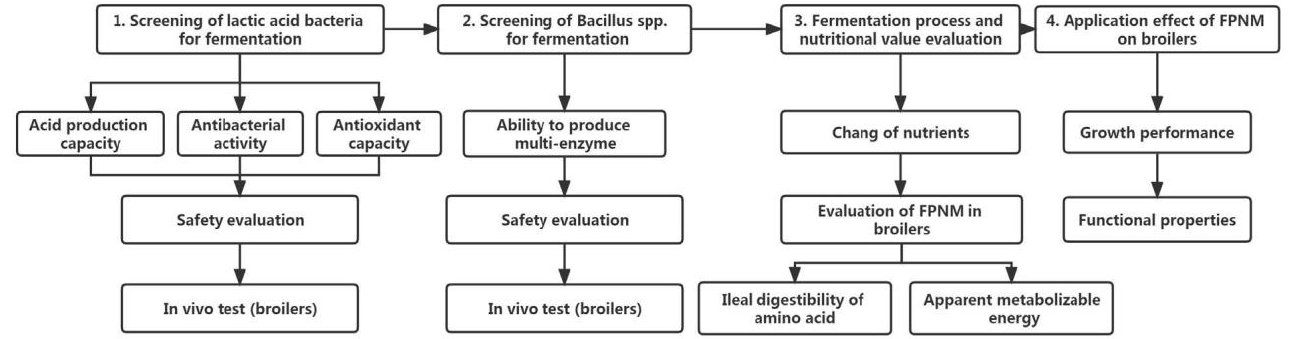
Figure 4. The technical route of the solid-state fermentation process of PNM and its application in broilers.